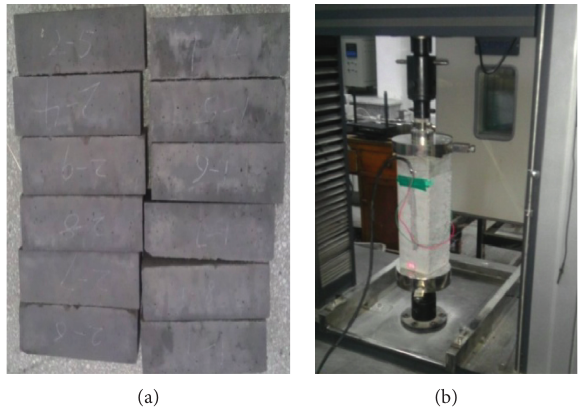
Figure 3: The test parameter of concrete material characteristic. (a) Test block. (b) Material property test.